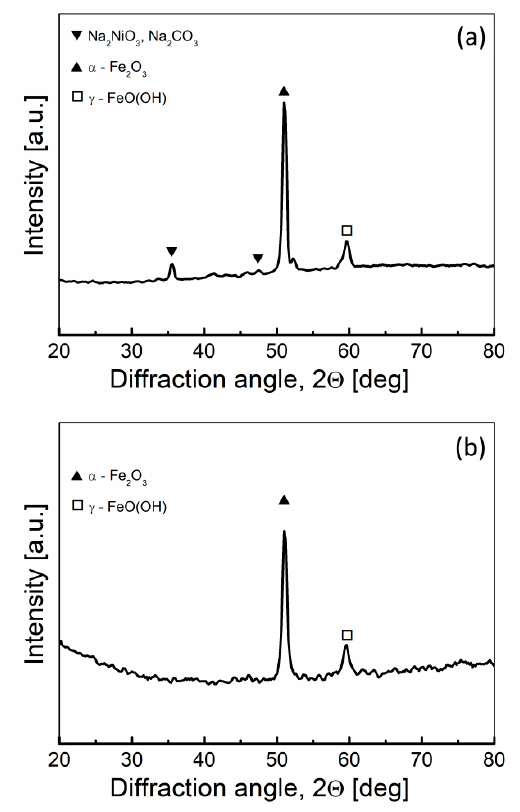
Figure 19. XRD patterns recorded for the elements of the Model II MH-DCFC: ( a ) anode, ( b ) cathode.